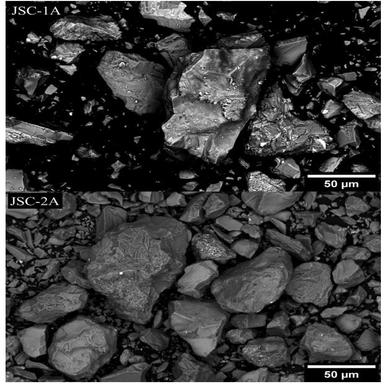
A comparison of JSC-1A (top) and JSC-2A (bottom) showing differences in particle shape. The more spherical JSC-2A particles lead to greater mixture workability compared to JSC-1A.